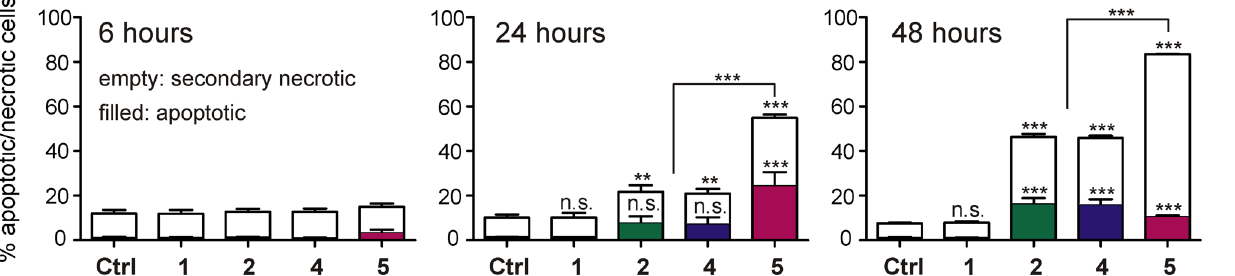
Fig 3. Induction of apoptosis in Jurkat cells. Results of annexin V/propidium iodide staining, performed after incubating Jurkat cells with compounds 1 , 2 , 4 and 5 at a concentration of 10 μ M for different periods. Annexin V + /PI - cells were defined as early apoptotic, whereas secondary apoptotic cells were annexin V + /PI + . Significances illustrated on top of the columns refer to the overall effect (apoptotic + secondary necrotic cells), those depicted in the columns refer to apoptotic cells. After 48 hours, apoptotic and secondary necrotic cells were significantly different (p < 0.001) (mean ± SEM, N = 3). One-way ANOVA and Bonferroni ’ s post-test were applied to calculate the significance of the apoptotic fraction and the sum of apoptotic and secondary necrotic cells; n.s.: not significant; * : p < 0.05; ** : p < 0.01, *** : p <